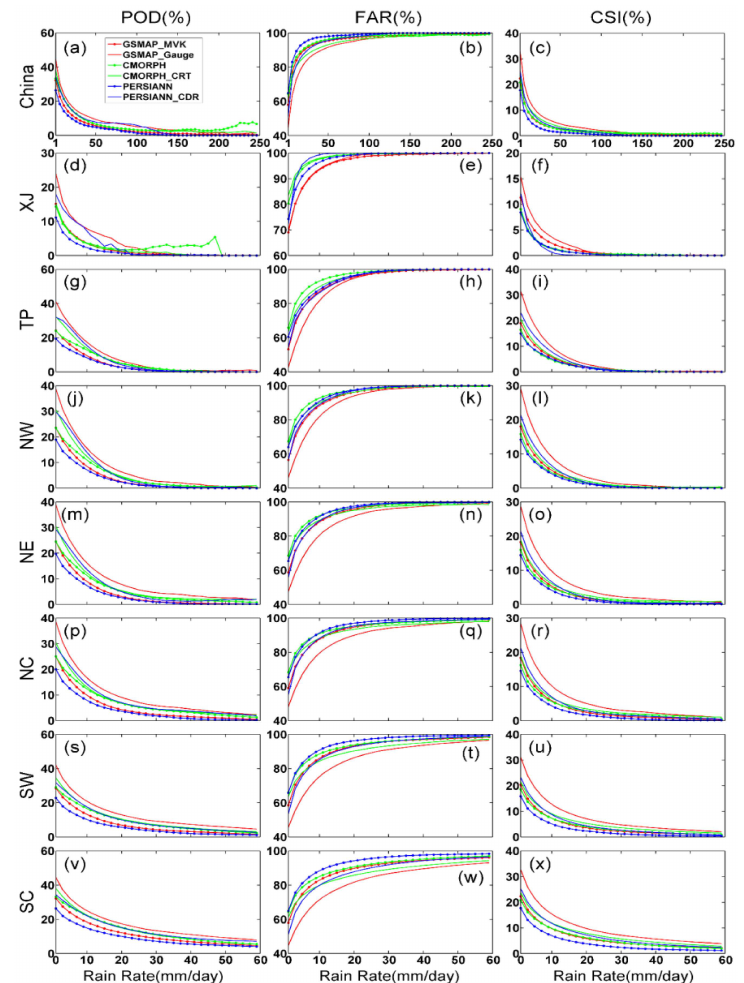
Figure 9. Contingency metrics of POD (left column panels), FAR (middle column panels) and CSI (right column panels) for different products over China and seven sub-regions for ( a – c ) China; ( d – f ) XJ; ( g – i ) TP; ( j – l ) NW; ( m – o ) NE; ( p – r ) NC; ( s – u ) SW; ( v – x ) SC, based on 0.25 ˝ lat/lon and daily mean precipitation rates (mm/day) day by day. Vertical axis scales were set according to the maximum of y -axis in different subpanels. The calculation of contingency metrics are derived using a 5 mm/day rain rate interval from 1 mm/day to 250 mm/day for mainland China and 2 mm/day interval from 1 mm/day to 60 mm/day for seven sub-regions. Only grid cells where there is at least one reporting gauge and both the reference and the satellite-based precipitation estimates are nonzero can be selected for computing these